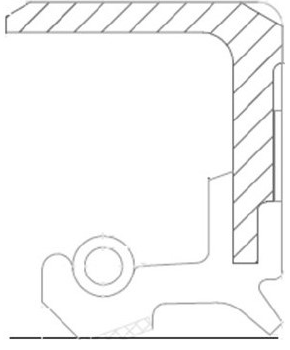
Figure 2. Engineering drawing of the exact radial lip oil seal used in this experiment, with a dust lip and a PTFE coating bonded to the elastomeric seal material.